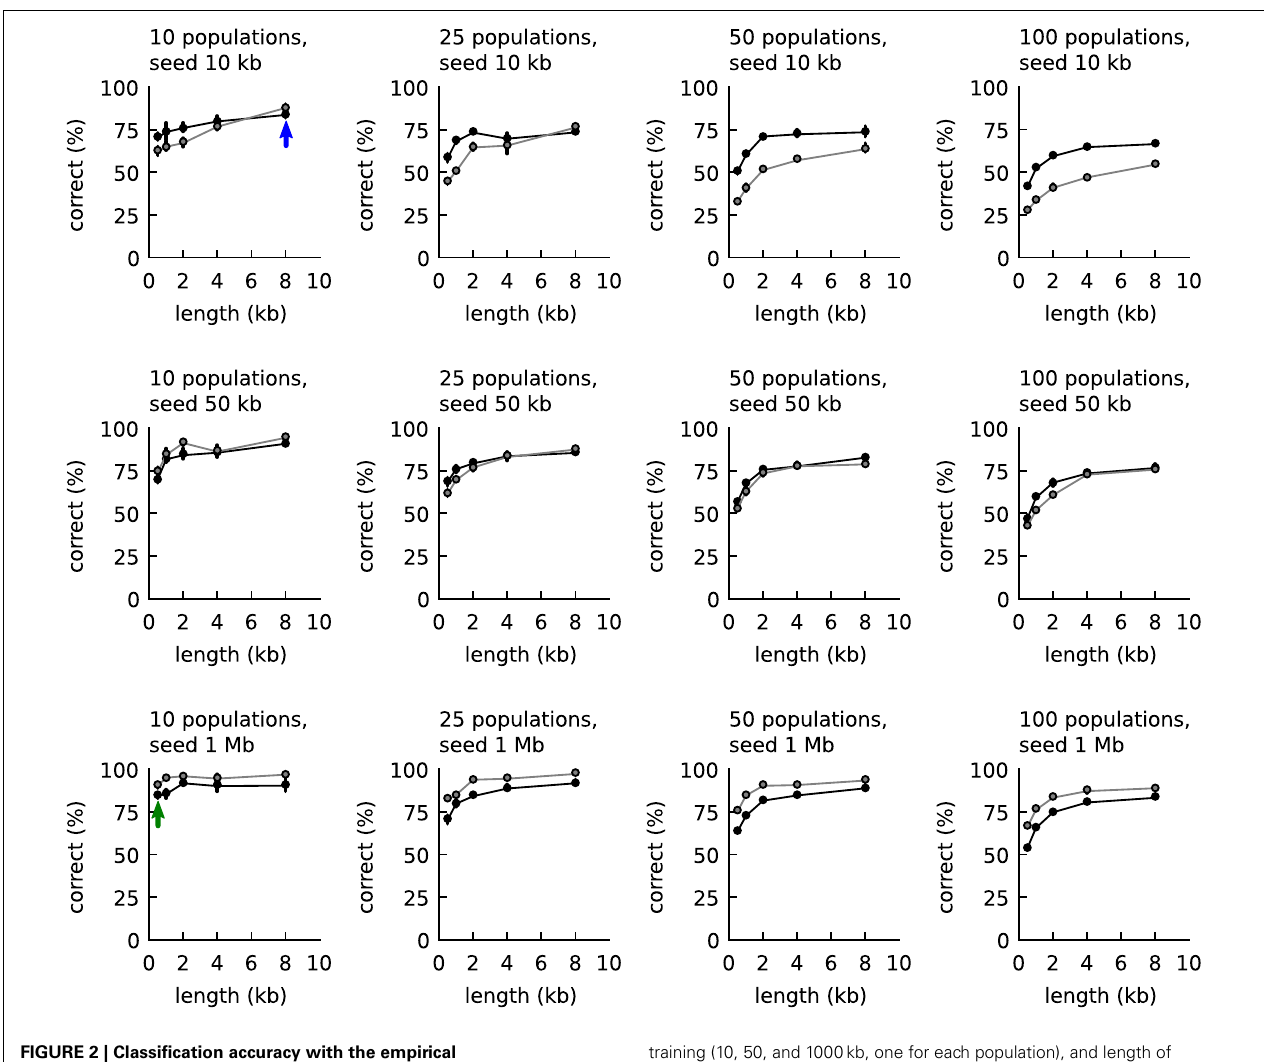
FIGURE 2 | Classification accuracy with the empirical relationships of Figure 1 (black line, closed symbols) and Interpolated Markov models (gray lines and symbols). The accuracy was calculated as function of community complexity (10, 25, 50, and 100 populations), length of the long DNA fragments used for